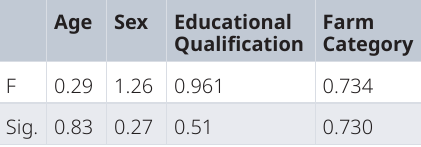
Table 8. Demographic variables and respondents’ perception of turnover.